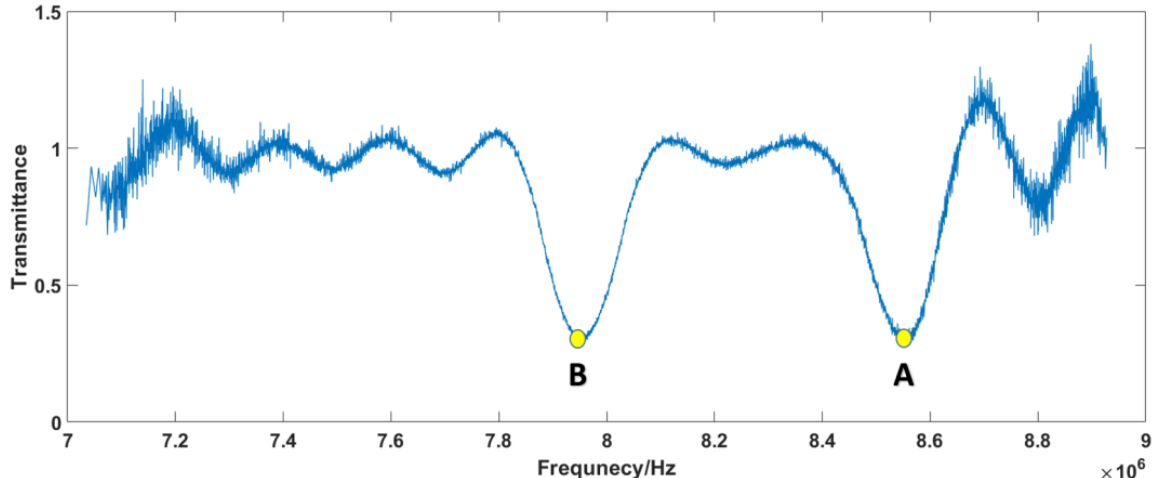
Figure 7. ( a ) Normalized RF spectra of simulation signal; ( b ) Magnified view of the components.